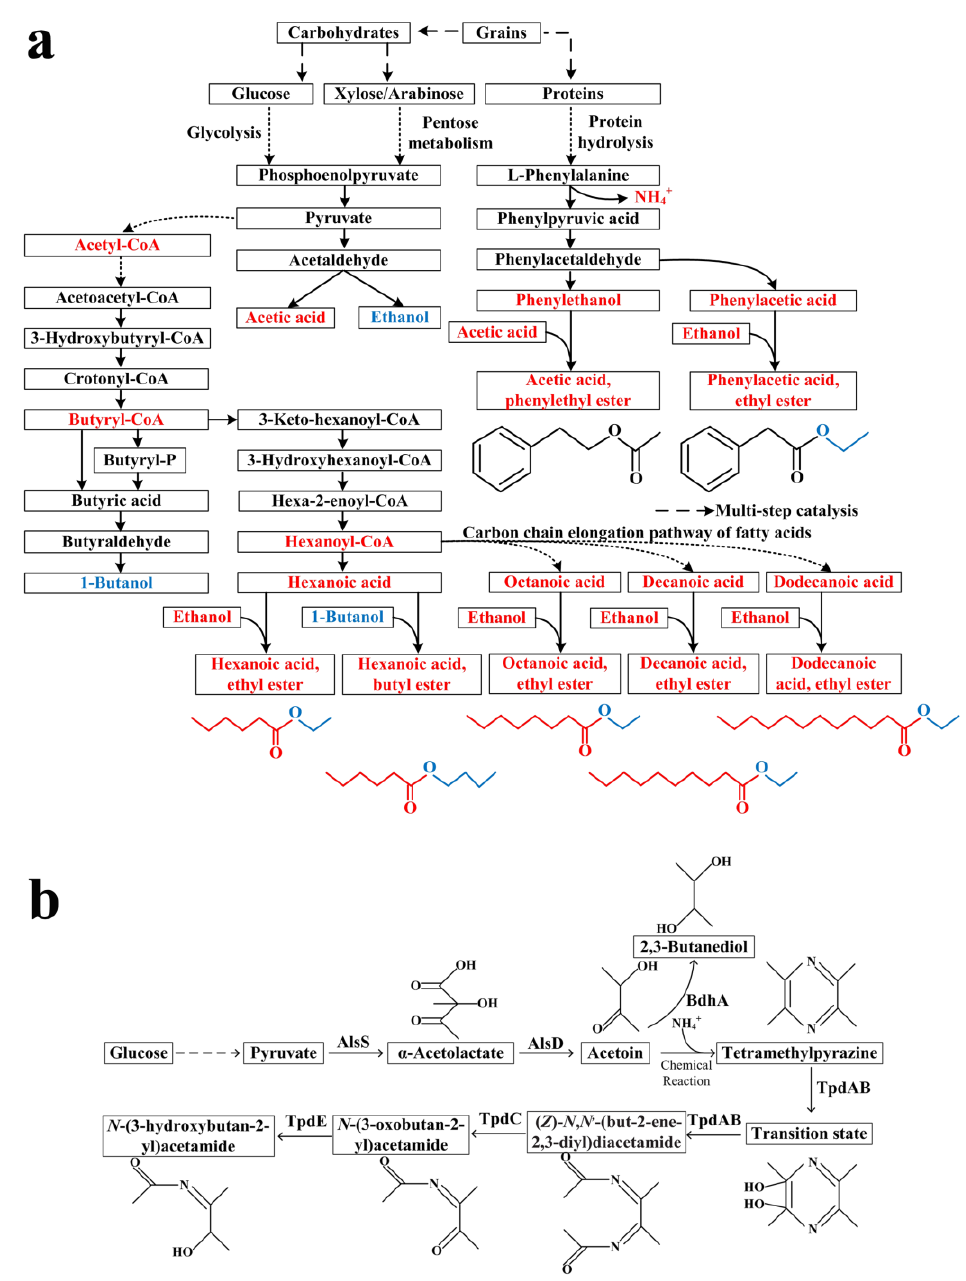
Figure 9. The synthetic pathway of esters ( a ) and the synthetic and degrading pathway of tetramethylpyrazine ( b ).